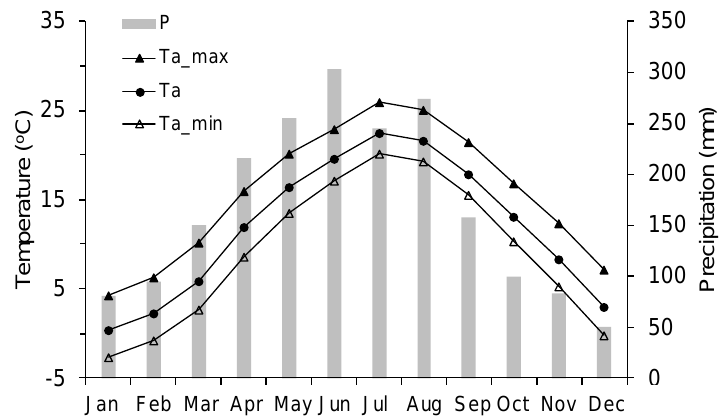
Figure 1. Monthly maximum (Ta_max), mean (Ta), minimum (Ta_min) temperatures and monthly precipitation (P) of Lushan from 1980 to 2011.